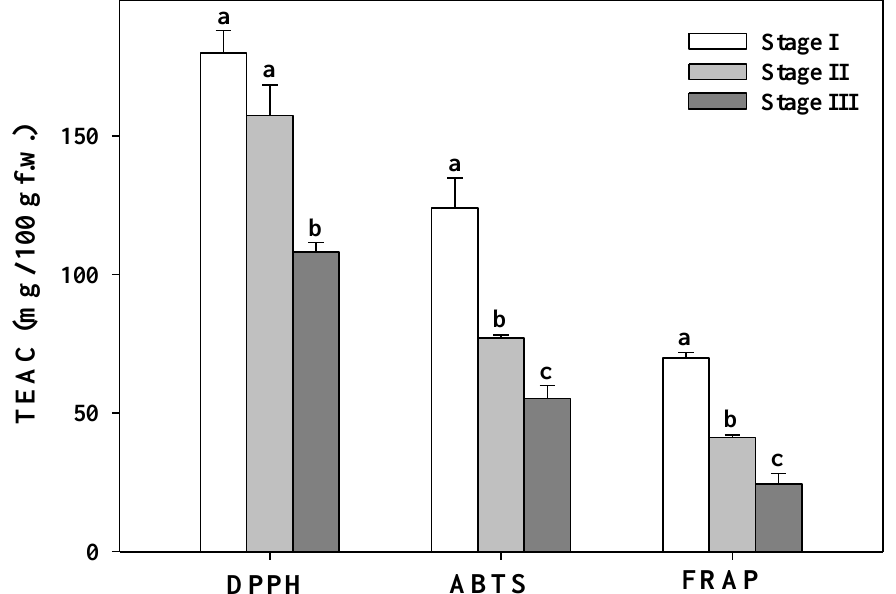
Figure 6 . Antioxidant capacity evaluated by three different assays (DPPH, ABTS, and FRAP) at different maturity stages of Aloe vera flowers. Stage I: immature; stage II: mature; stage III: mature, with flowers buds opened (mean ± SD, n = 3). a–c Different letters show significant differences ( p < 0.05) among the maturity stages.